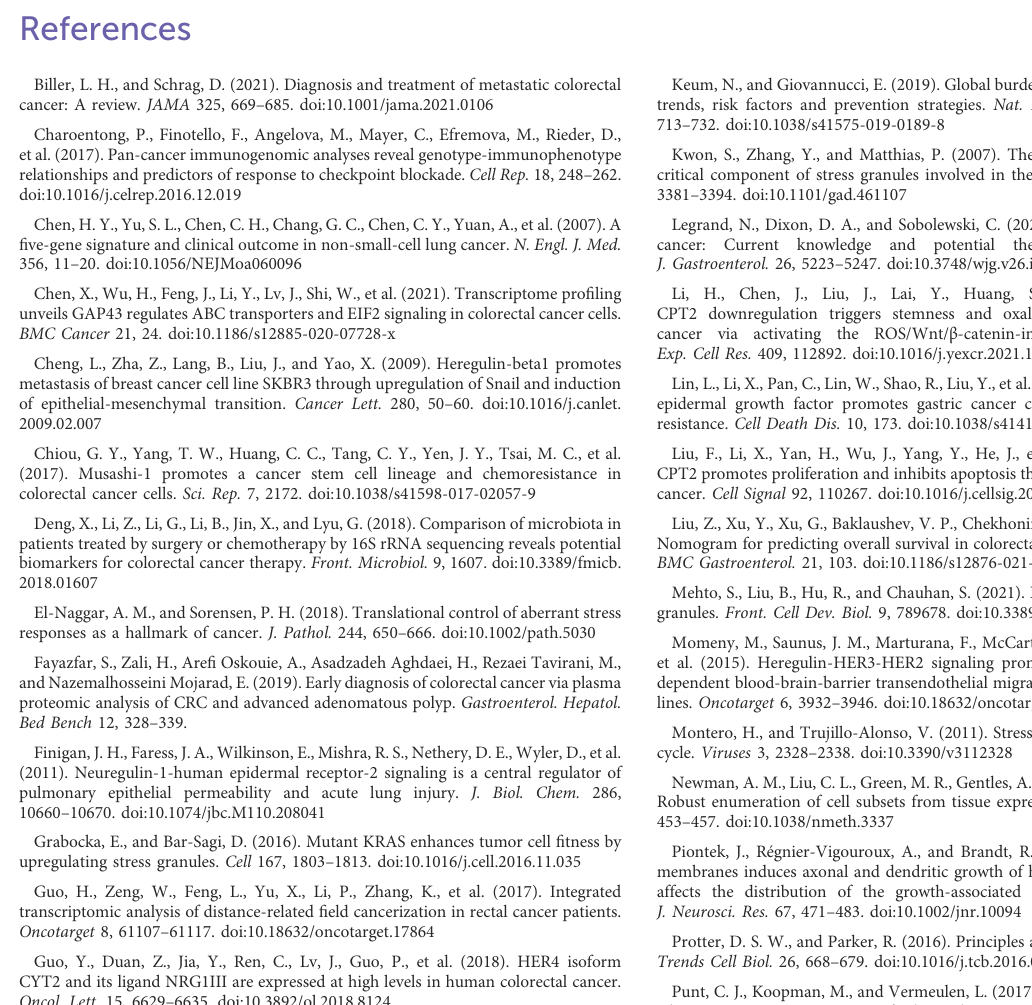
database for external validation. (F) The risk score in colorectal cancer specimen derived from TCGA database. The clinical outcome information was provided by cBioPortal database